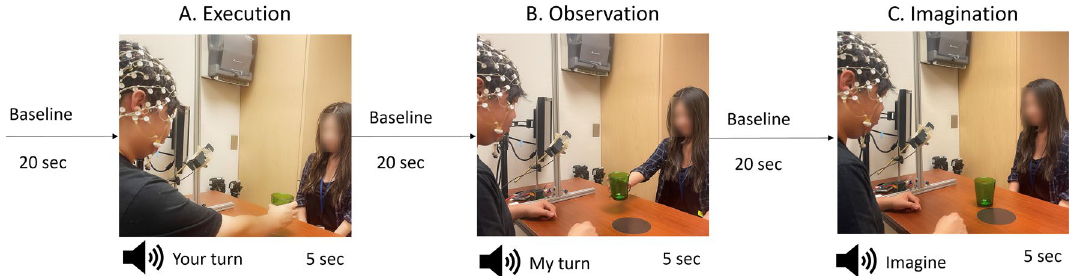
Figure 1. Experimental setup for each condition: ( A ) Execution, ( B ) observation, ( C ) imagination. Written permission has been taken for publication of participant